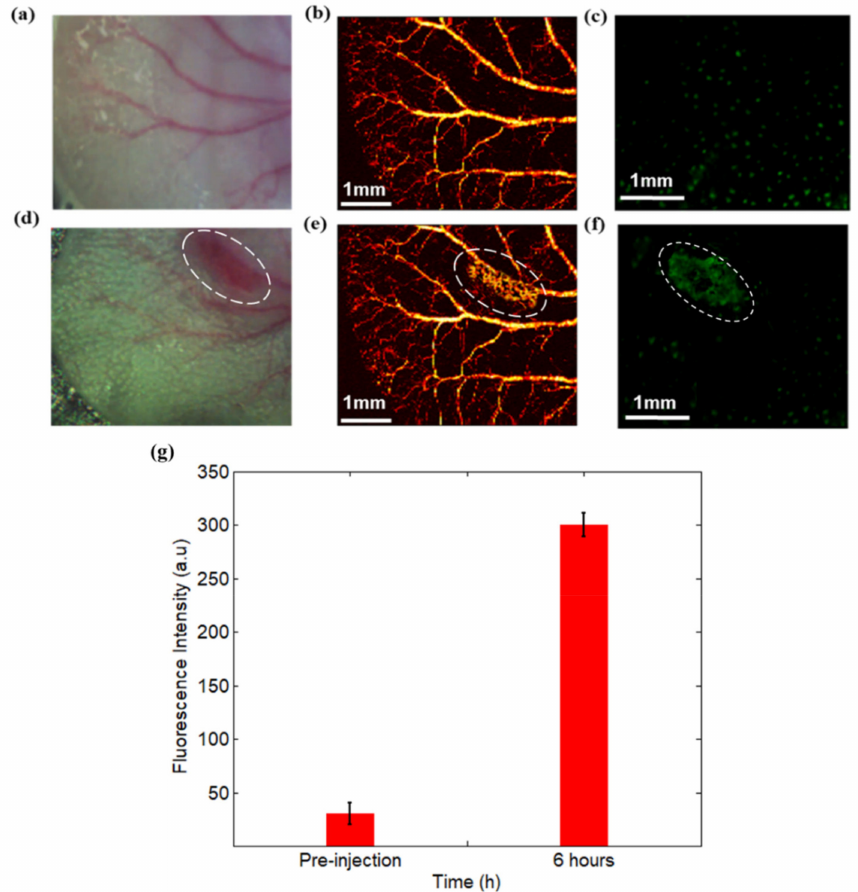
Figure 4. Dual-modal PAM and fluorescence microscopy imaging results for the first mouse. ( a ) The photography of normal mice ear; ( b ) PAM imaging of normal mice ear; ( c ) fluorescence microscopy imaging of normal mice ear; ( d ) photography of the same mice ear at 6 h post-injection; ( e ) PAM imaging of immunovascular response of mice ear with inflammation at 6 h post-injection; ( f ) fluorescence microscopy imaging of the bacteria distribution and inflammation regions of mice ear at 6 h post-injection; and ( g ) the corresponding fluorescence intensity at pre-injection and 6 h